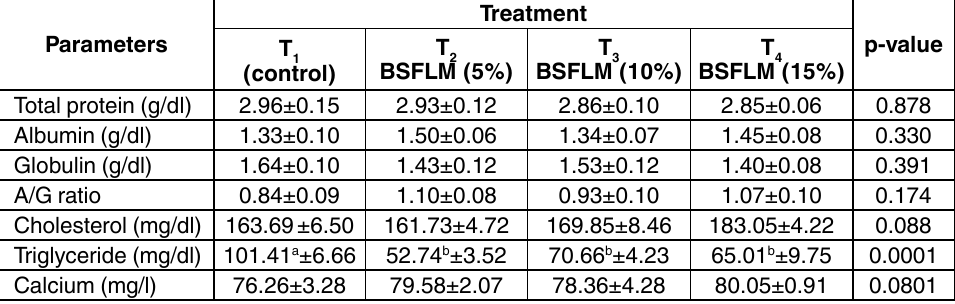
Table 6. Mean (±SE) serum parameters of meat type ducks in different dietary treatments at eight weeks of